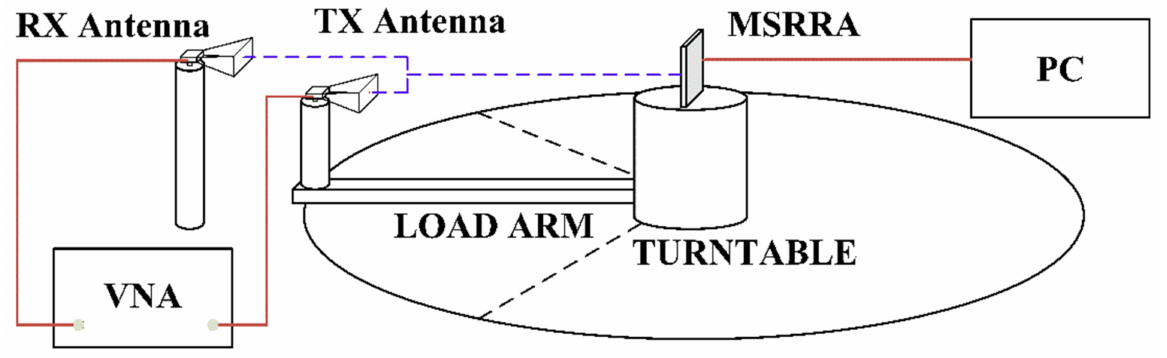
Figure 5. Block diagram of experimental scheme.